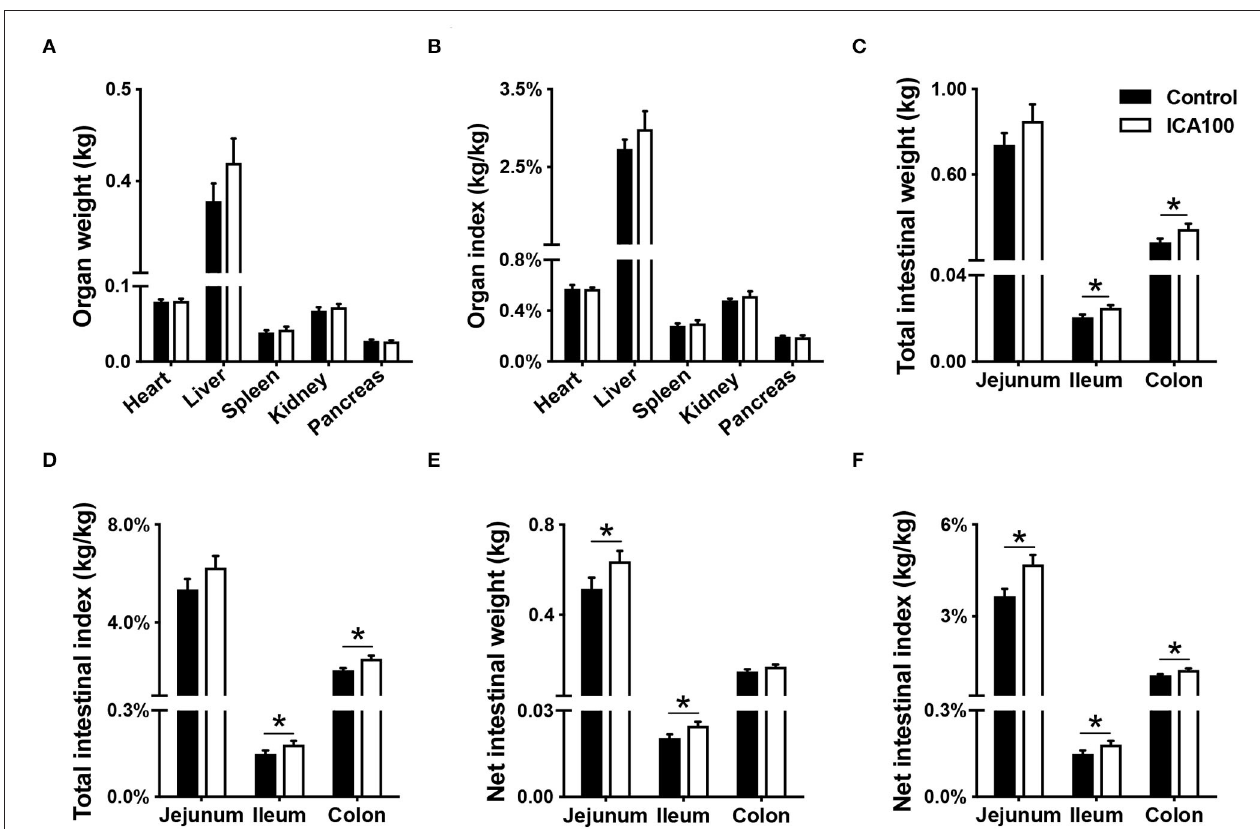
FIGURE 1 | Effects of dietary ICA supplementation on organ indexes of weaned piglets. The weight (A) and organ index (B) of the heart, liver, spleen, kidney and pancreas in the control and ICA100 groups. The total intestinal weight (C) , total intestinal index (D) , net intestinal weight (E) , and net intestinal index (F) in the control and ICA100 groups. Data are expressed as mean ± SEM. * P < 0.05 vs. the Control group. ICA100, the basal diet supplemented with 100 mg/kg indole-3-carboxaldehyde.